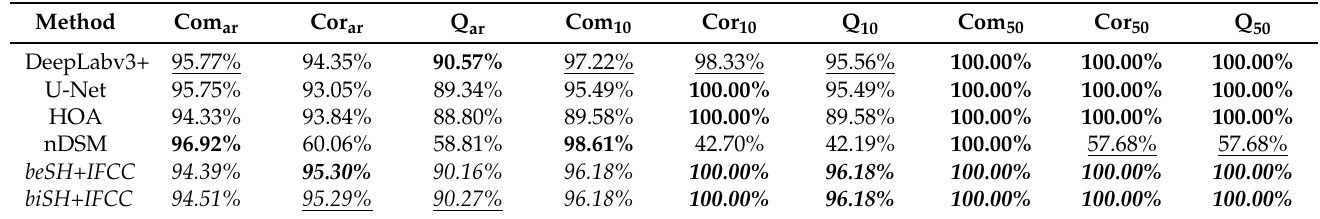
Table 4. Average quantitative evaluation results of different methods on the three test areas.